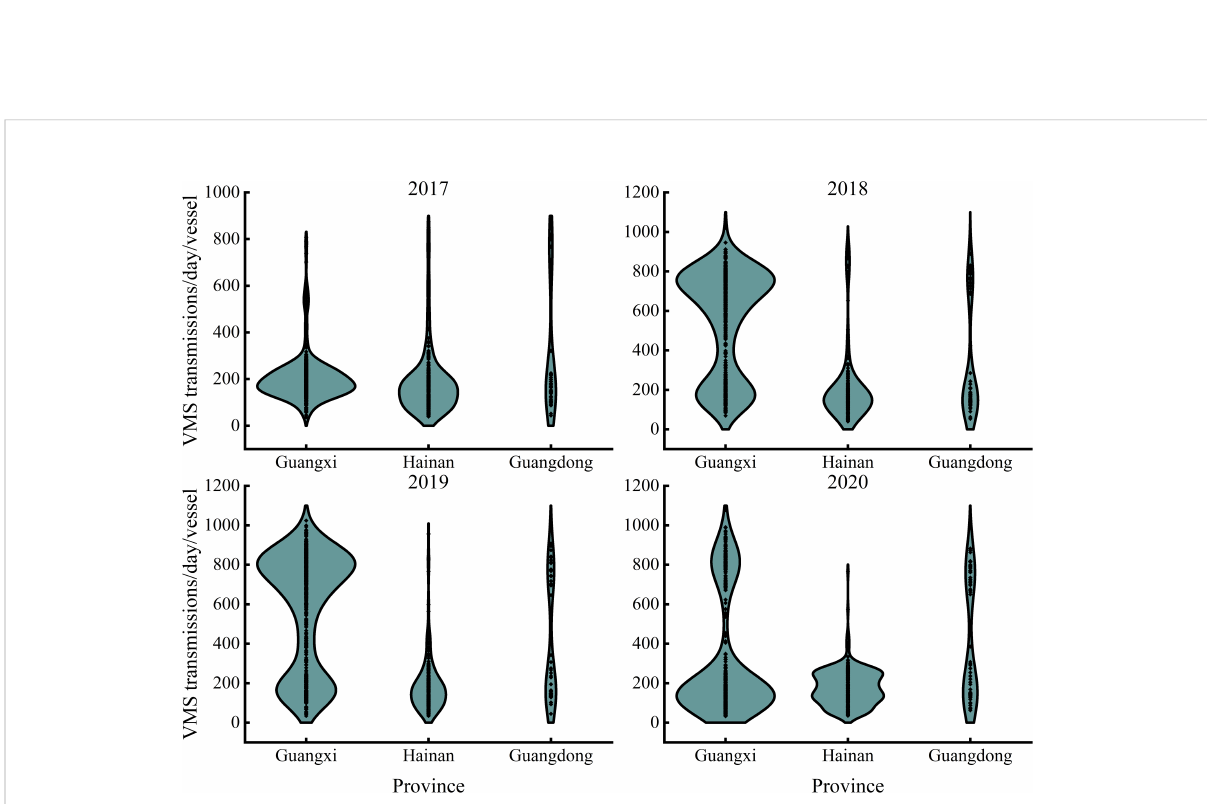
FIGURE 5 Average numbers of vessel monitoring system transmissions per vessel per day for the different